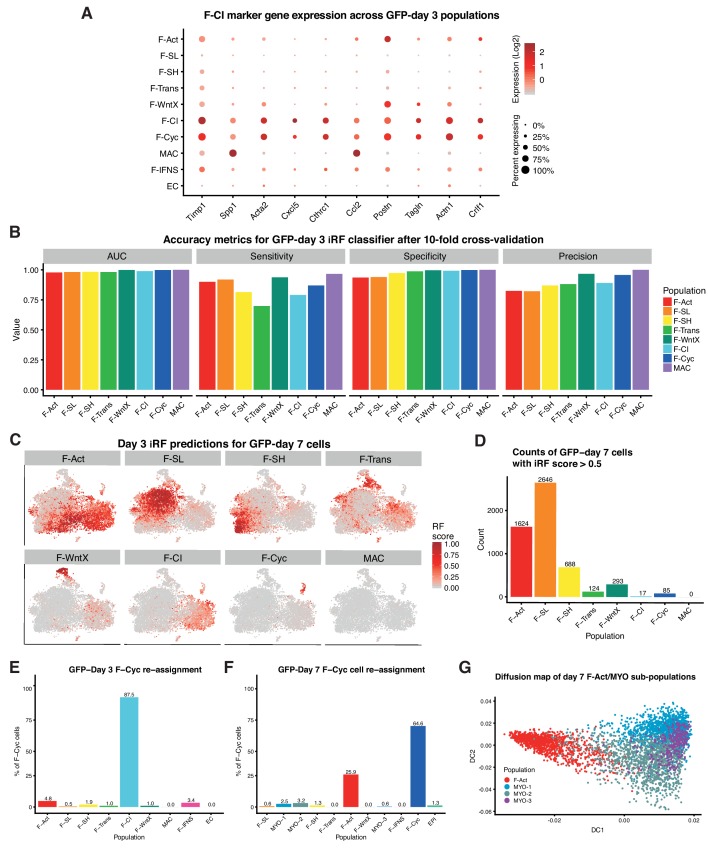
Reanalysis of GFP-day 3 and GFP-day 7 data-sets separately.(A) Expression of F-CI marker genes on GFP-day 3 dot plot (B) AUC, sensitivity, specificity and precision for iRF classifier trained to predict GFP-day 3 cell populations after 10-fold cross-validation. (C) iRF prediction scores for GFP-day 7 cells as visualized on t-SNE plots. (D) Counts of GFP-day 7 cells predicted to correspond to GFP-day 3 populations as determined by iRF prediction (score >0.5). (E) Percentage of GFP-day 3 F-Cyc cells reassigned to alternative populations after removing cell cycle genes. (F) Percentage of GFP-day 7 F-Cyc cells reassigned to alternative populations after removing cell cycle genes. (G) 2D Diffusion Map plot of F-Act, MYO-1, MYO-2 and MYO-3 from the GFP-day 7 data-set.